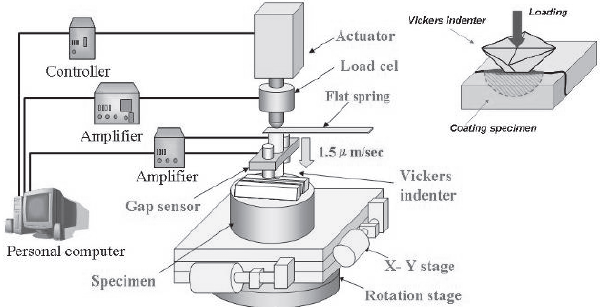
Figure 9. Schematic illustration of the instrumented indentation test equipment [39]. Reproduced with